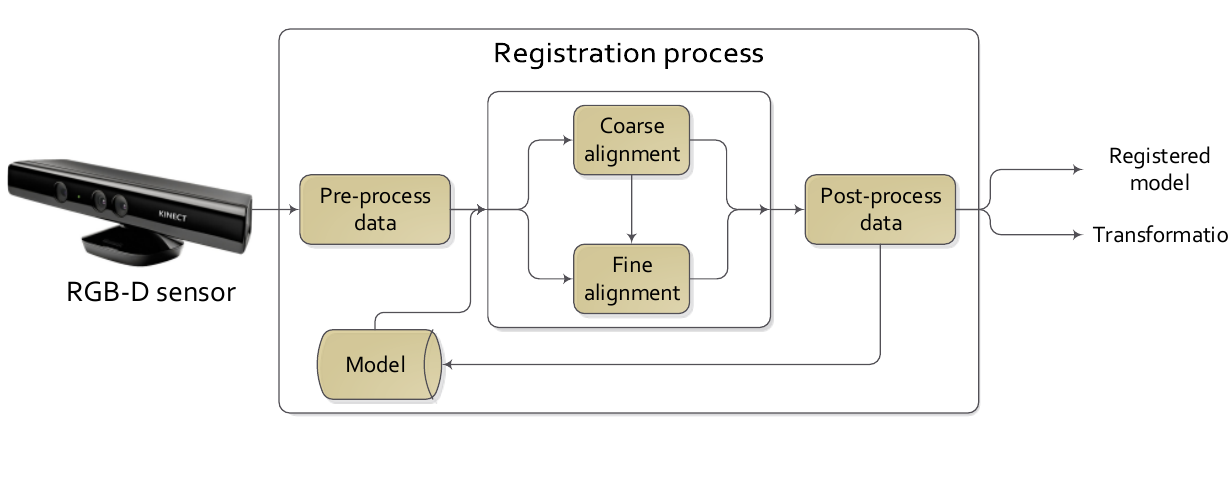
Figure 2. General scheme of the registration